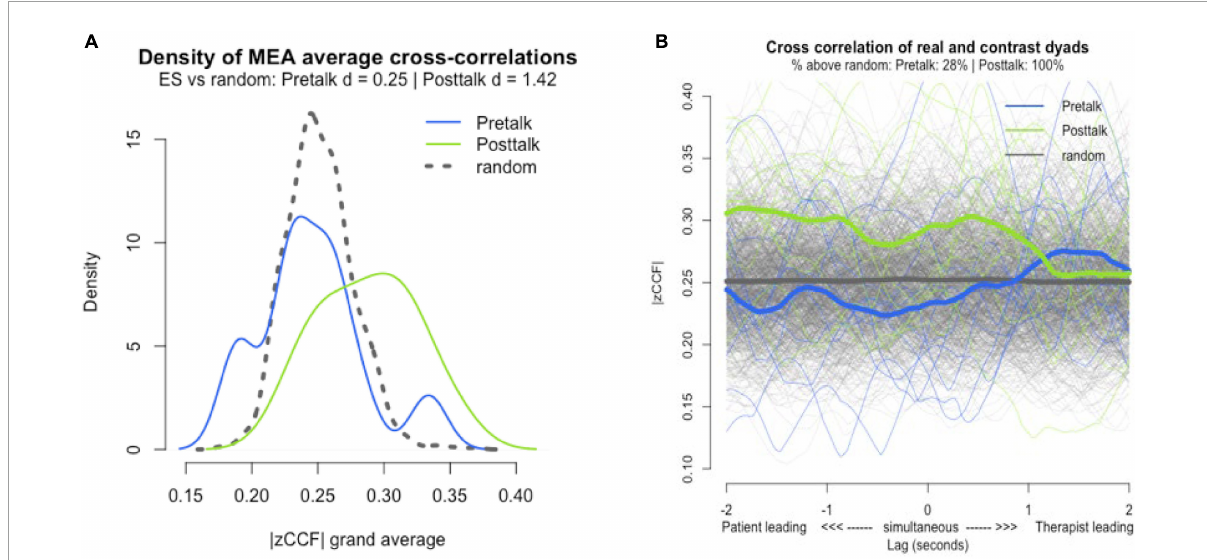
FIGURE4 Synchrony vs pseudosynchrony. (A) Effect size of pretalk, posttalk, and pseudosynchrony. |zCCF|, Fisher’s Z absolute mean cross-correlation. (B) Lag-plot of pretalk and posttalk synchrony. Gray line = pseudosynchrony